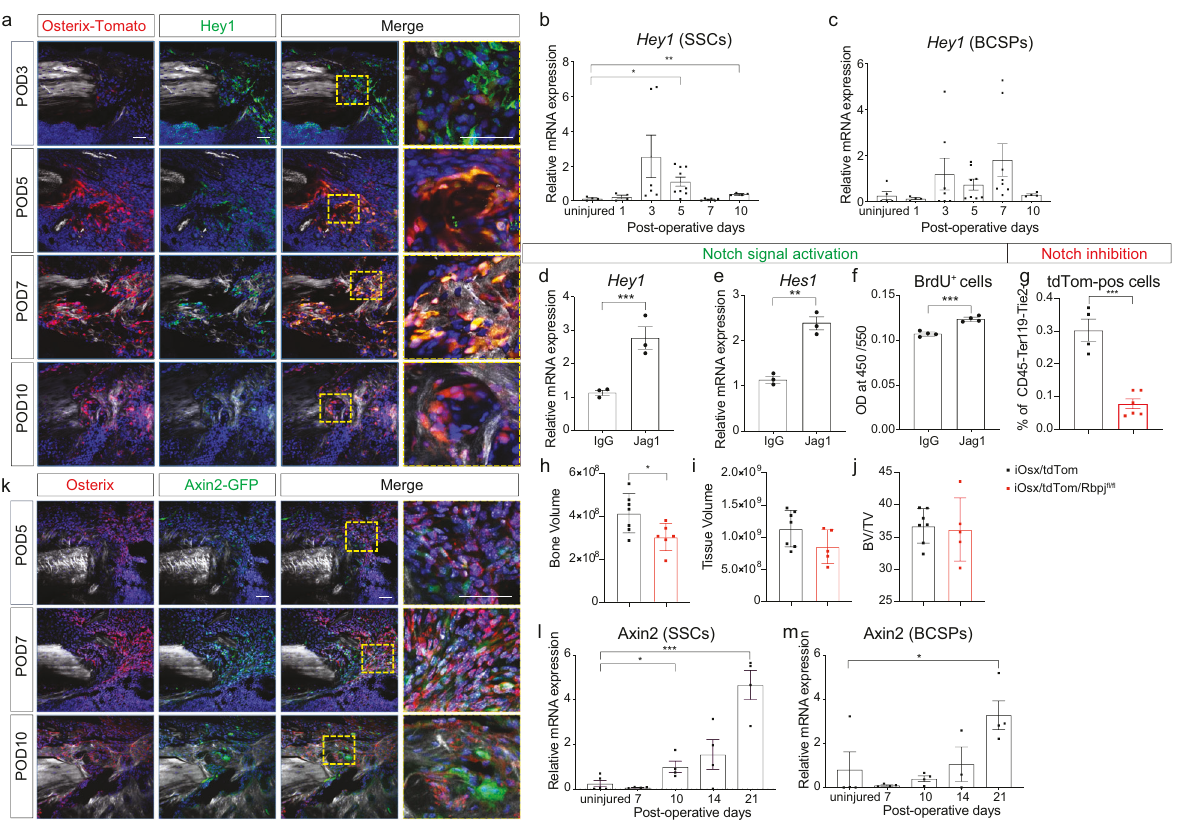
Fig. 2 Notch signaling dominates the proliferative phase while canonical Wnt signaling governs the differentiation phase. a Temporospatial expression pro fi le of Notch downstream target Hey1 by immunostaning and co-localization with osterix-positive cells. To label osterix-positive cells, iOsx/tdTom mice were pulsed by tamoxifen injection (1 mg/day/mouse) twice at 1 day before surgery and 1 day after surgery. b , c Temporal Notch downstream target gene expression during the early injury response (uninjured, POD 1 – 10) in SSCs and BCSPs ( n = 6 – 9). d , e Notch activation using Jagged1-coated tissue culture plates resulted in upregulation of the Notch target genes Hey1 and Hes1 . f In response to Notch activation, proliferation increased, shown by BrdU quanti fi cation. g The number of tdTomato-positive ( osx -positive OPCs) cells decreased in the POD 3 injury site after Notch inhibition in iOSX/tdTom/Rbpj fl / fl mice. Tamoxifen (1 mg/day/mouse) was injected from day − 1 until day 2. h Bone volume, i tissue volume, and j bone volume/total volume, at postoperative day 10 using microCT histomorphometry demonstrates a smaller bone volume in the regenerate in the iOSX/tdTom/Rbpj fl / fl mice (tamoxifen (1 mg/day/ mouse daily) from day − 1 to day 6). k Spatial expression of Wnt responsiveness within osx -positive (IF) OPCs using iAxin2/GFP reporter mice (Tamoxifen administration: 1 day before euthanasia). Scale bar = 50 μ m. l , m Axin2 gene expression SSCs and BCSPs in uninjured and POD 7 – 21 days ( n = 4). BCSP bone-cartilage-stromal progenitor cells, Jag1 Jagged1, POD postoperative day, SSC skeletal stem cell. * p < 0.05, ** p < 0.01, *** p < 0.001. Data were represented as mean ±